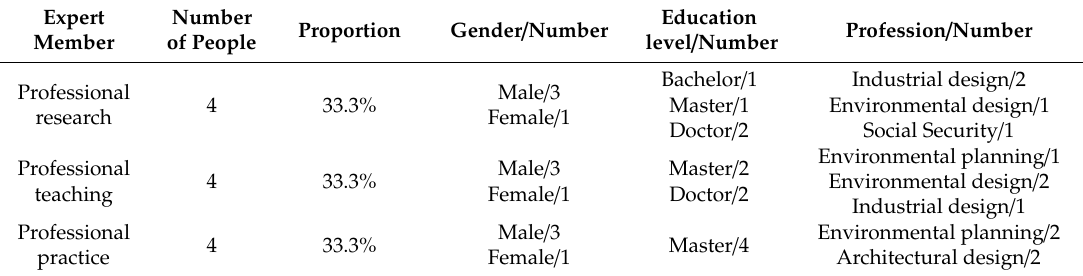
Table 3. Expert Basic